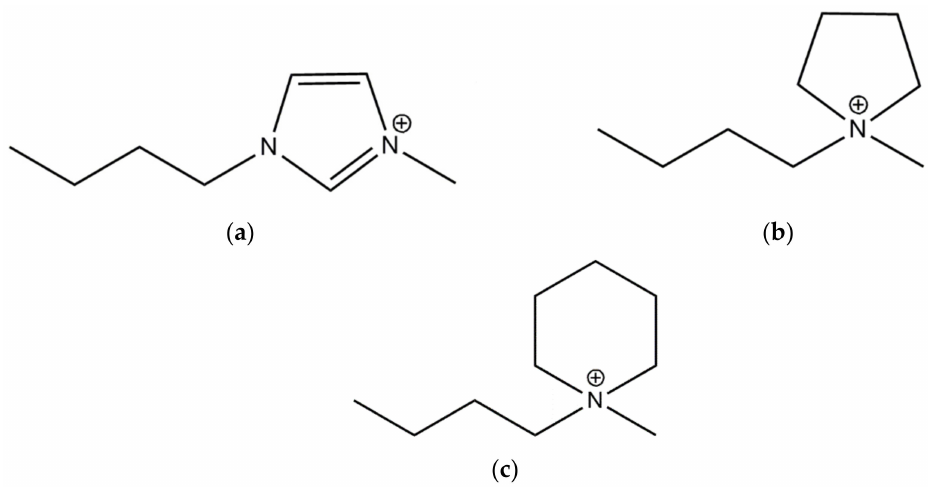
Figure 1. Structure of IL cations: ( a ) 1-butyl-3-methylimidazolium; ( b ) 1-butyl-1-methylpyrrolidinium; ( c ) 1-butyl-1- methylpiperidinium.